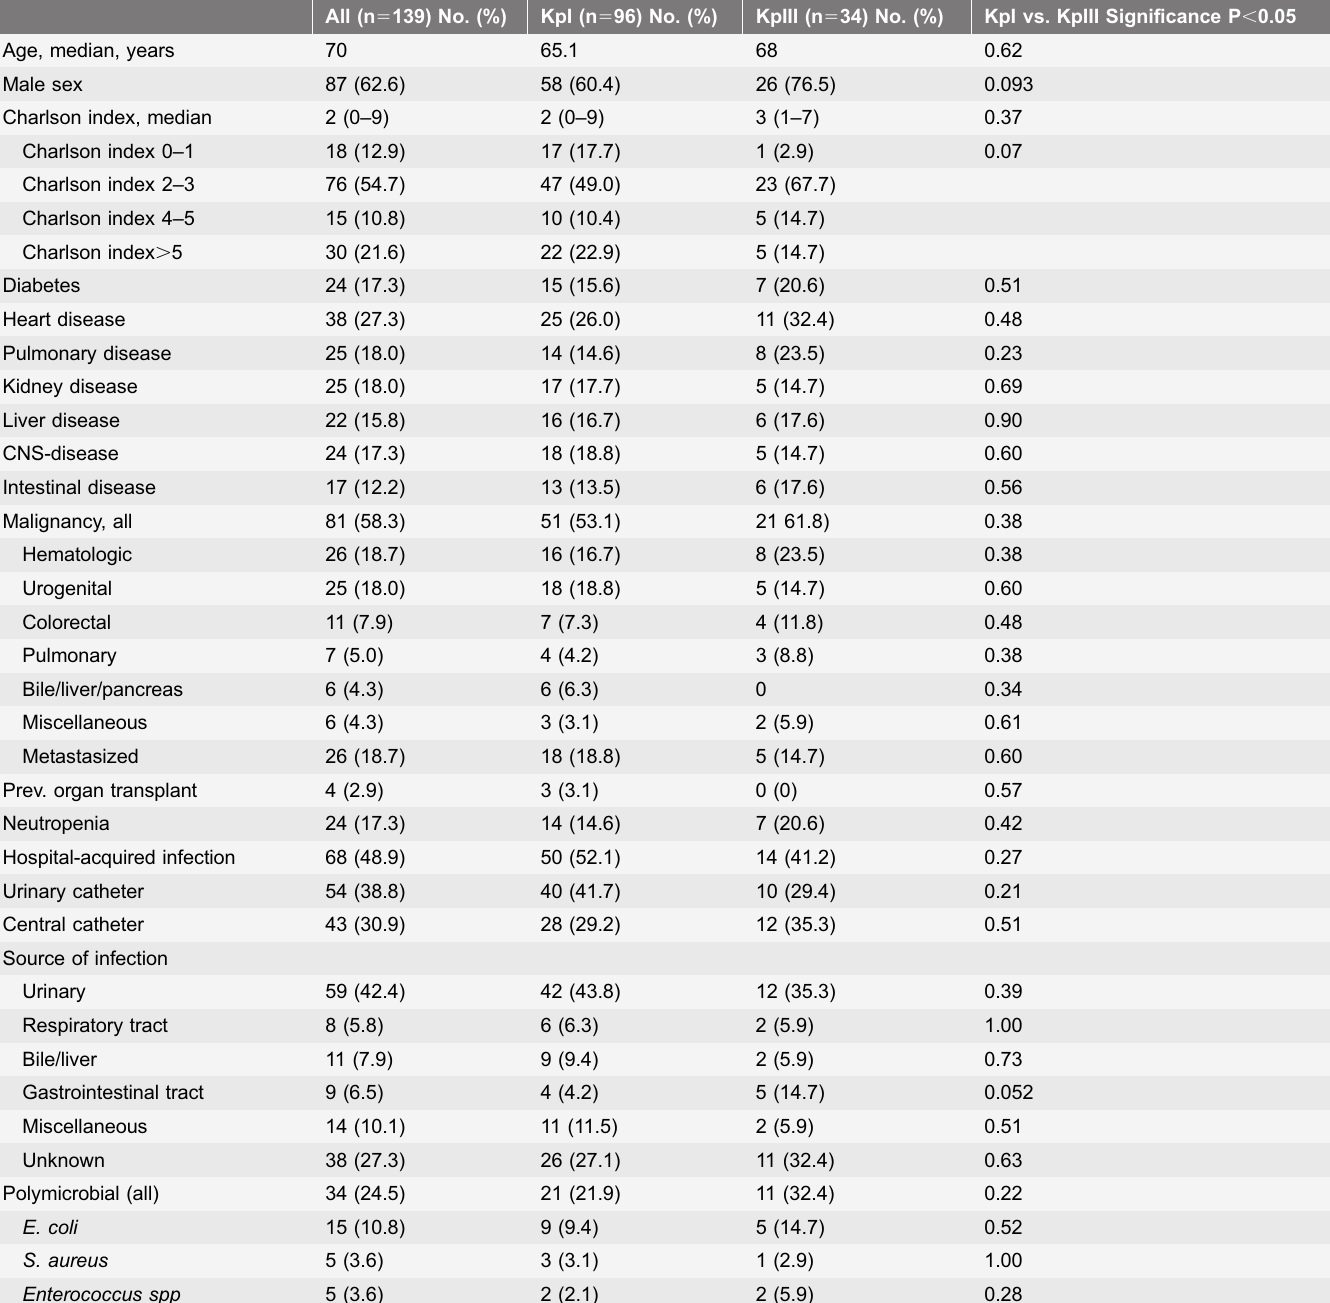
Table 4. Clinical characteristics of patients with invasive infection caused by K. pneumoniae/variicola